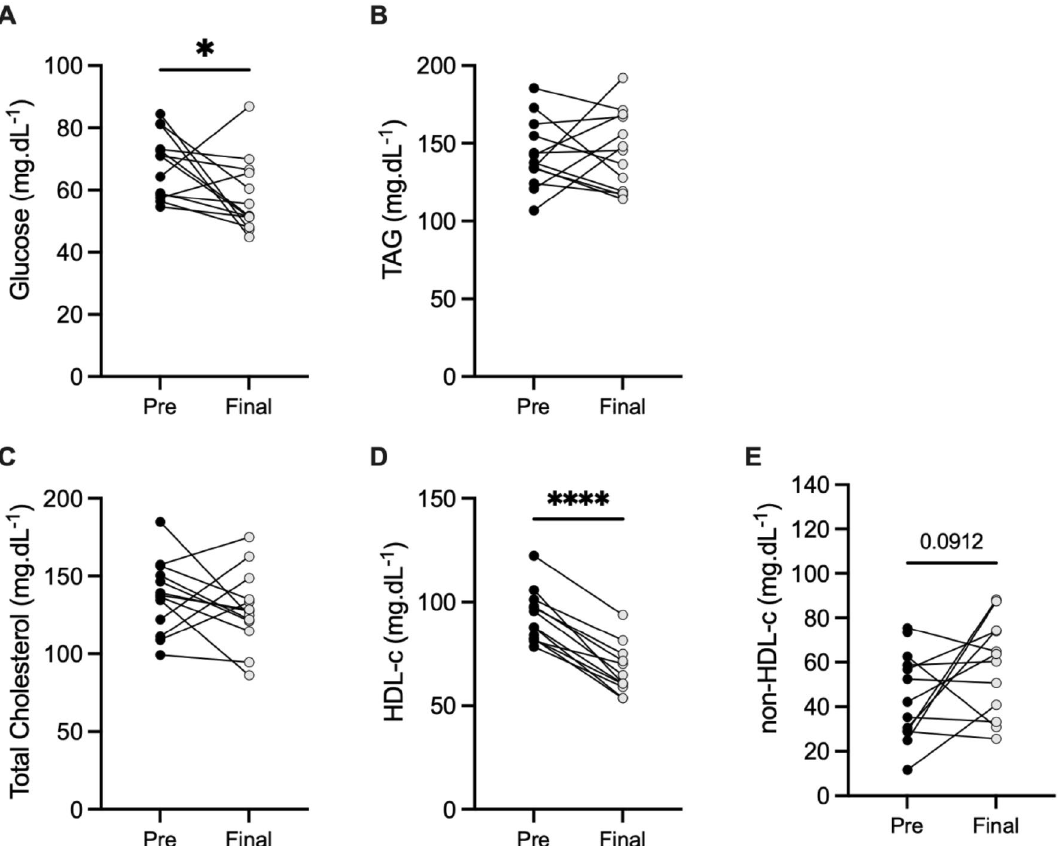
Figure 1. Resting metabolic values before and after badminton season for all individual participants. Individual data points (dots) for the total participants cohort (n = 13) ( A ) glucose, ( B ) triacylglycerol, ( C ) total cholesterol, ( D ) HDL-cholesterol (n = 12), ( E ) non-HDL-cholesterol (n = 12). *P-values indicate differences relative to pre- season resting